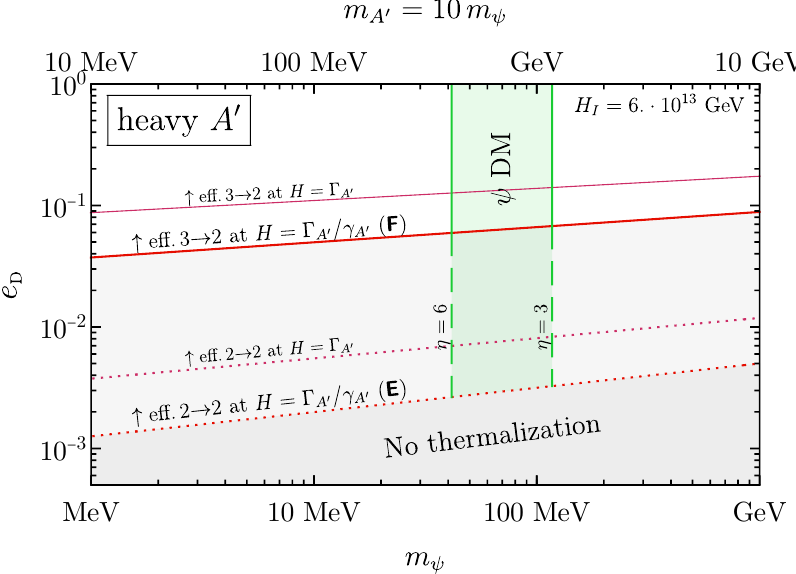
Figure 7. Parameter space where ψ reaches the DM abundance for the case of heavy A 0 ( m A 0 = 10 m ψ ), for H I = 6 · 10 13 GeV. The red lines mark the regions where the dark sector reaches chemical and kinetic equilibrium (respectively, 3 → 2 and 2 → 2 processes are efficient) before all the A 0 ’s decay to ψψ , accounting for the time dilation γ A 0 ∼ T dm /m A 0 . For comparison, the thinner violet lines show the rates at H = Γ A 0 . The green band (corresponding to a variation η = 3 − 6 ) shows where ψ achieves the correct DM relic